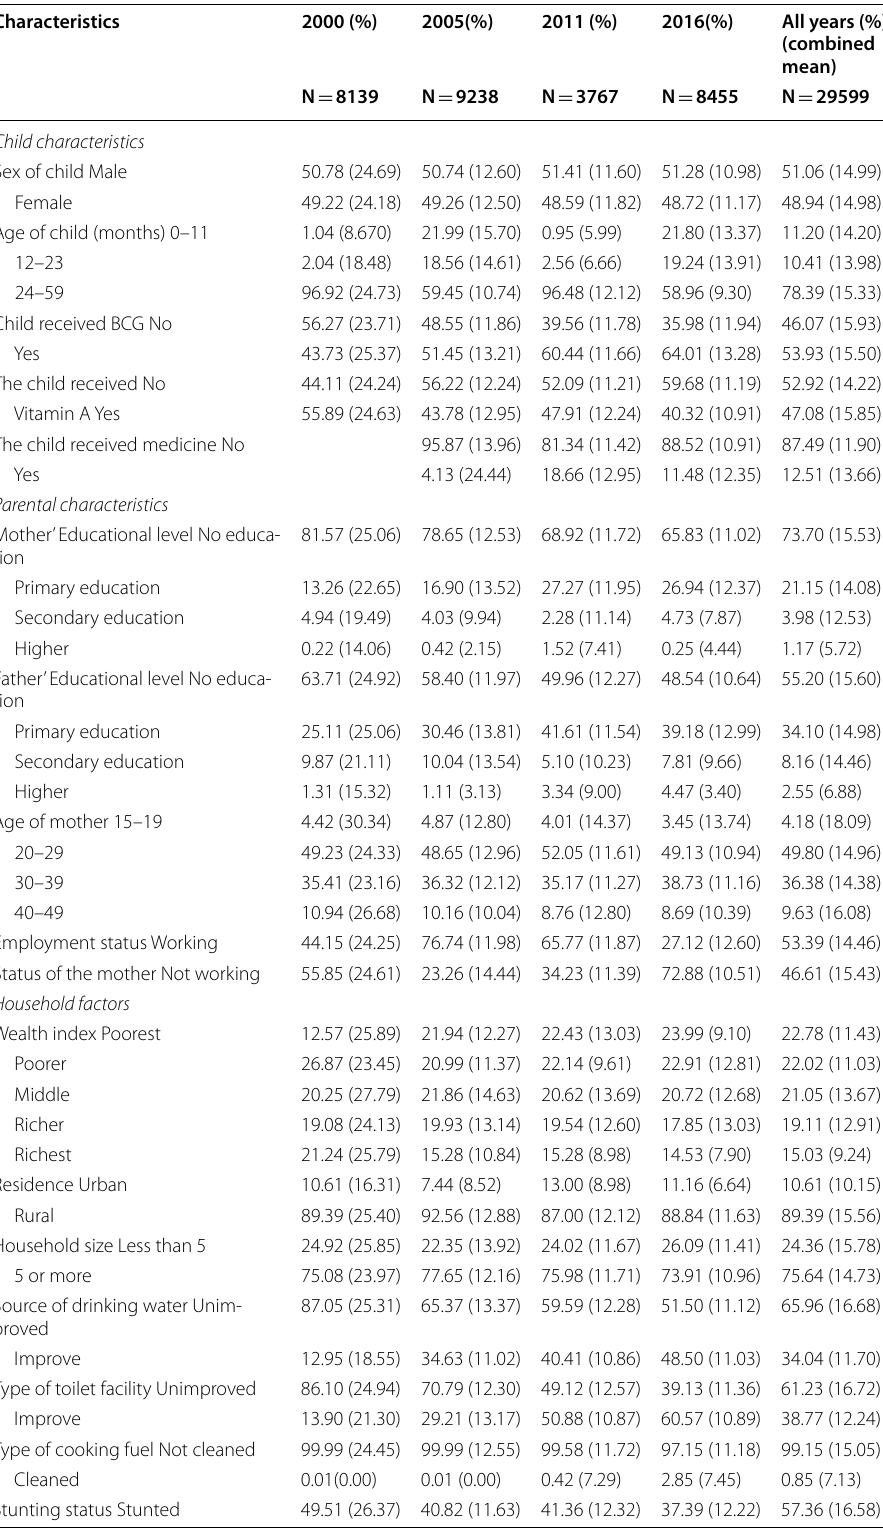
Table 1 Proportion of covariates and the prevalence of ALRIs (in parenthesis) within each covariate: